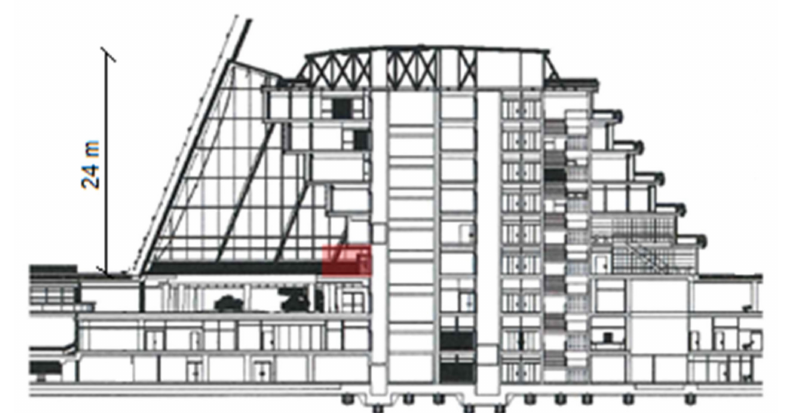
Figure 3. South-west and north-east side view [33].